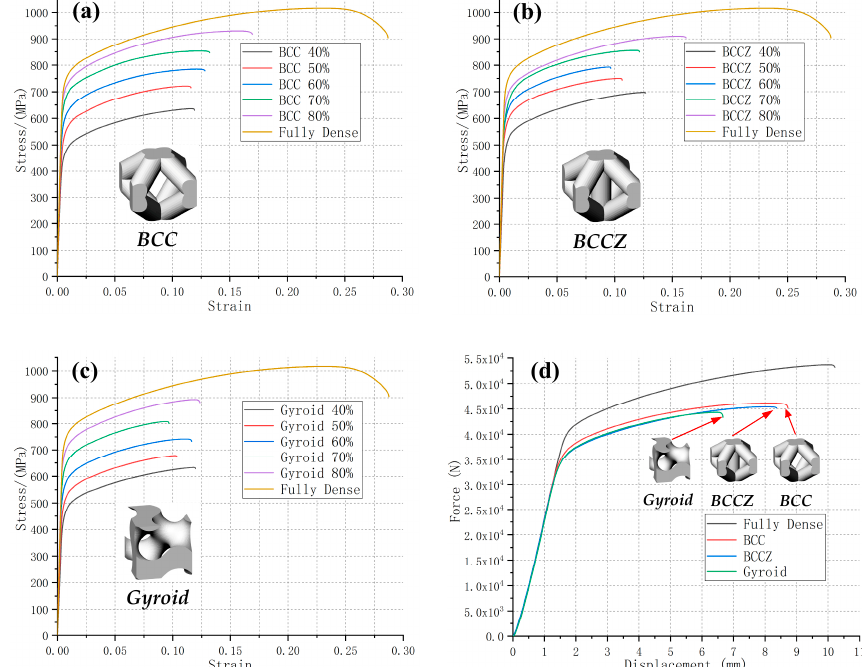
Figure 5. The stress-strain curves of metal lattice test specimens ( a ) BCC and ( b ) BCCZ, as well as ( c ) the gyriod TPMS porous test specimen, all with 40%–80% relative densities. The corresponding geometric model of the unit cell is provided. The stress-strain curve of the original test specimen was used as a reference. ( d ) The force-displacement curves of metal lattice test specimens BCC and BCCZ, as well as the gyriod TPMS porous test specimen, with a relative density of 80%. The force-displacement curve of the original test specimen was used as a reference.